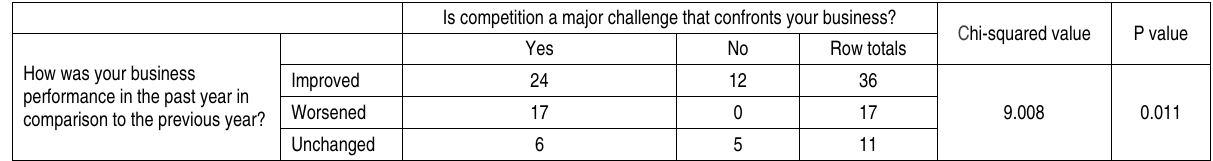
Table 7. Association between competition and business performance Is competition a major challenge that confronts your business?